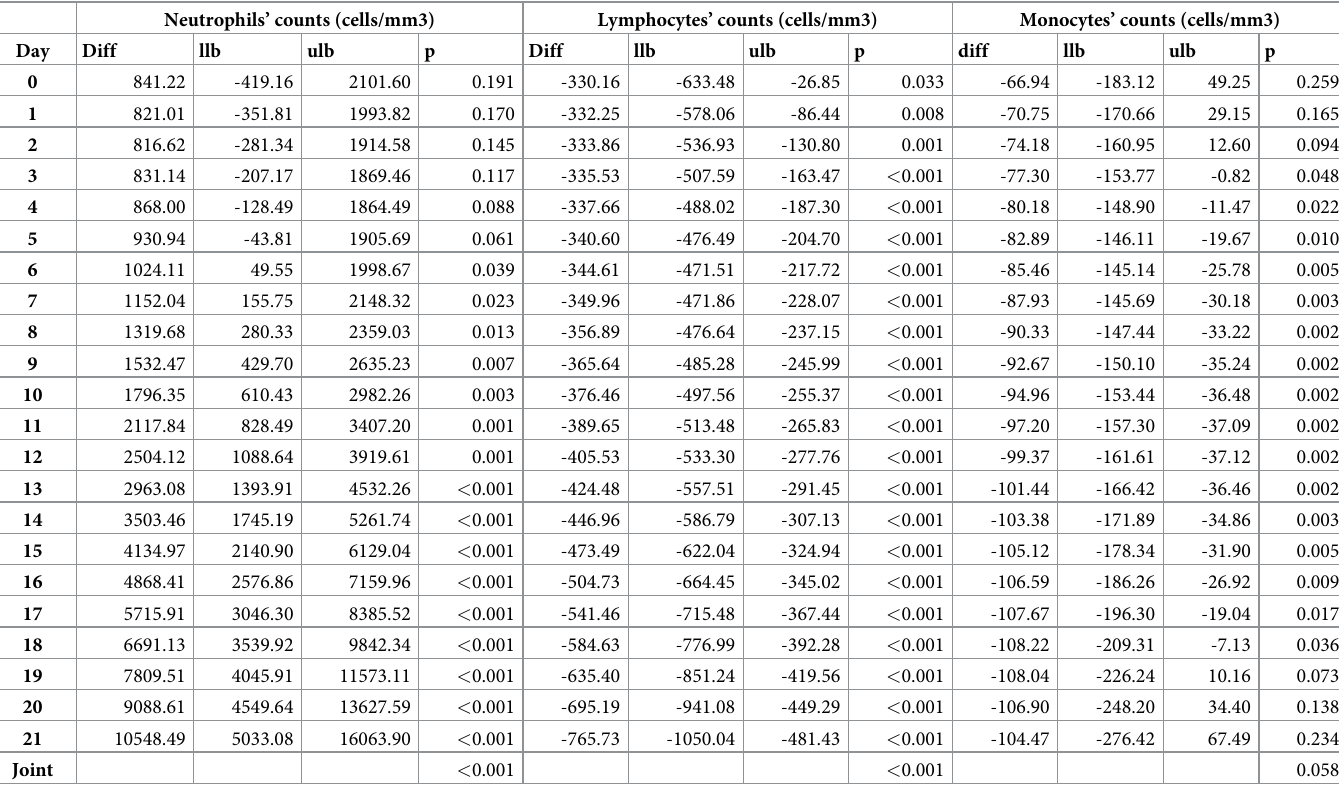
Table 2. Temporal evolution of the differences of neutrophils’, lymphocyte’s and monocytes’ counts, between survivors and non-survivors (diff). Neutrophils’ counts